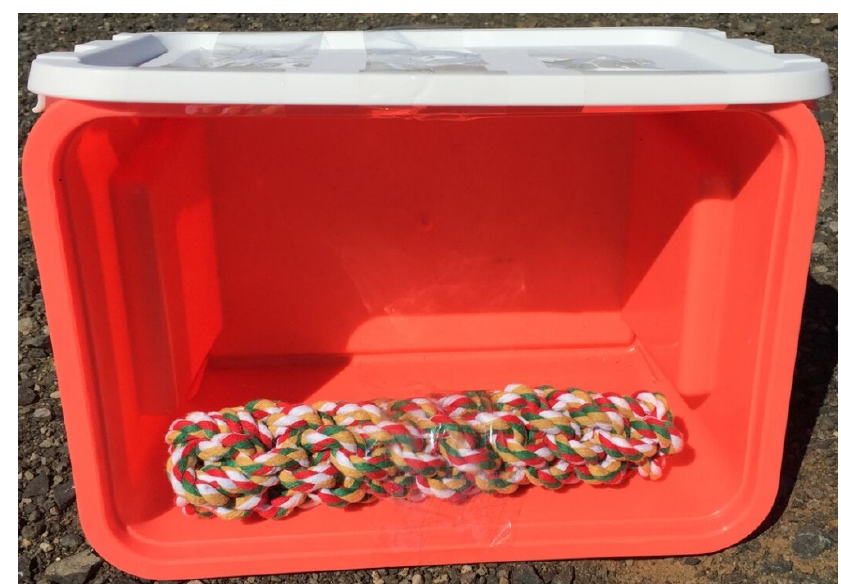
Figure 3. A dog play rope placed inside of a box was used for the Novel Object test and was fitted with a white lid on the top. The Novel Object was placed with the rope facing the hens.